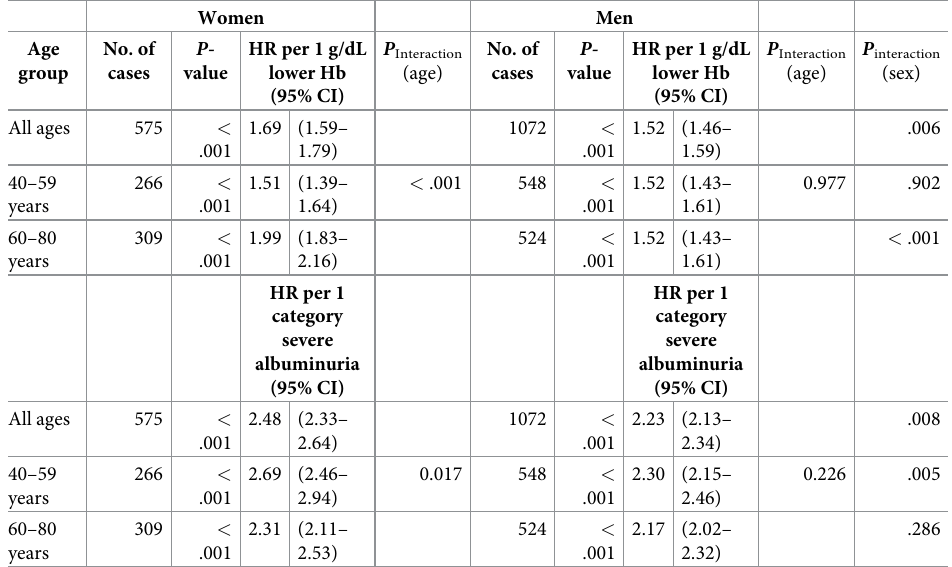
Table 3. HRs a per 1 g/dL decrease in Hb or per 1 category severe albuminuria for ESRD incidence by sex and